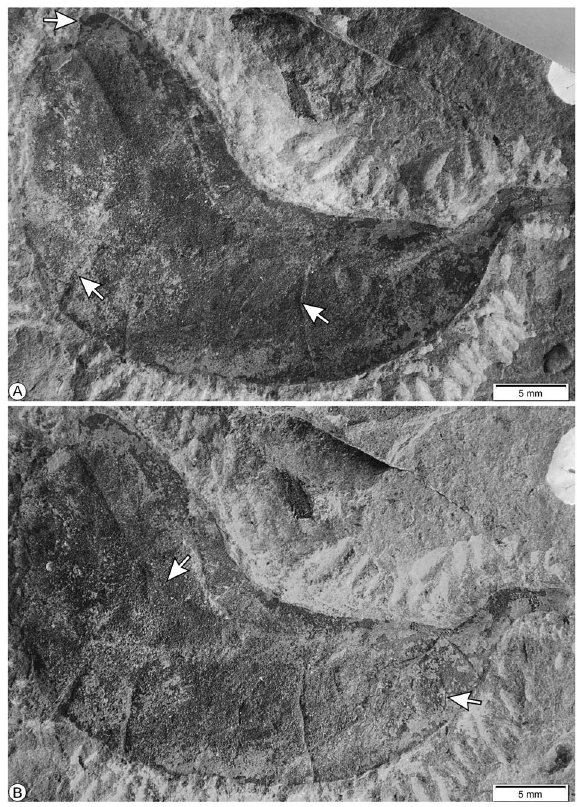
Fig. 1 Fossil fruit from the Olmos Formation, Holotype MUZ-3907. a General view of the fossil specimen, showing stylar base (upper arrow), and fracture marks (bottom arrows). b A partially opened suture (upper arrow), and patterns of venation (bottom arrow).